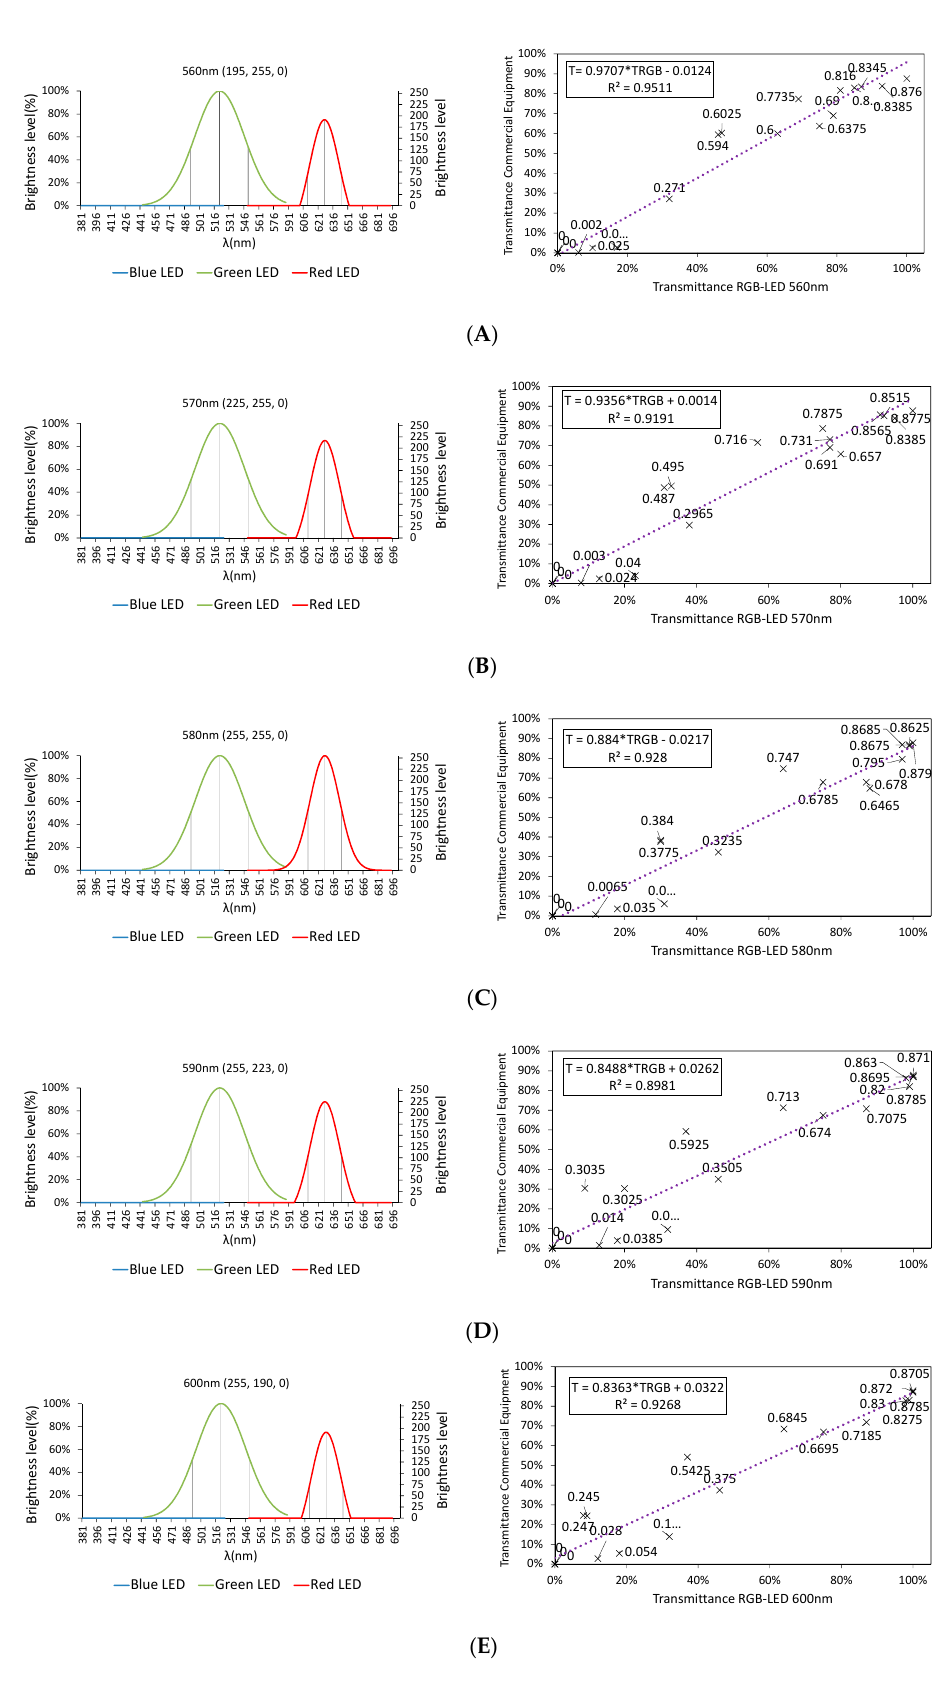
Figure 15. Combination of wavelengths and correlation for: ( A ) 560, ( B ) 570, ( C ) 580, ( D ) 590, and ( E ) 600 nm.